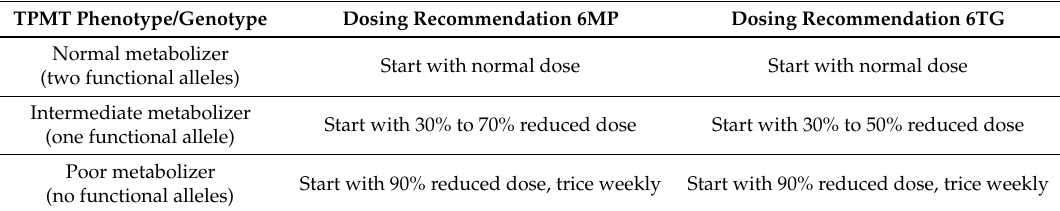
Table 2. Dosing guidelines for 6MP and TG based on the presence phenotype/genotype of TPMT. TPMT Phenotype/Genotype TPMT